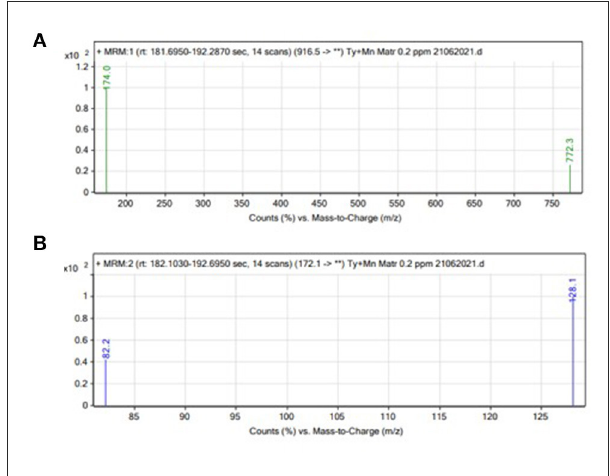
FIGURE1 Liquid chromatography tandem mass spectrometry spectrums of (A) Tyl and (B) MNZ production.